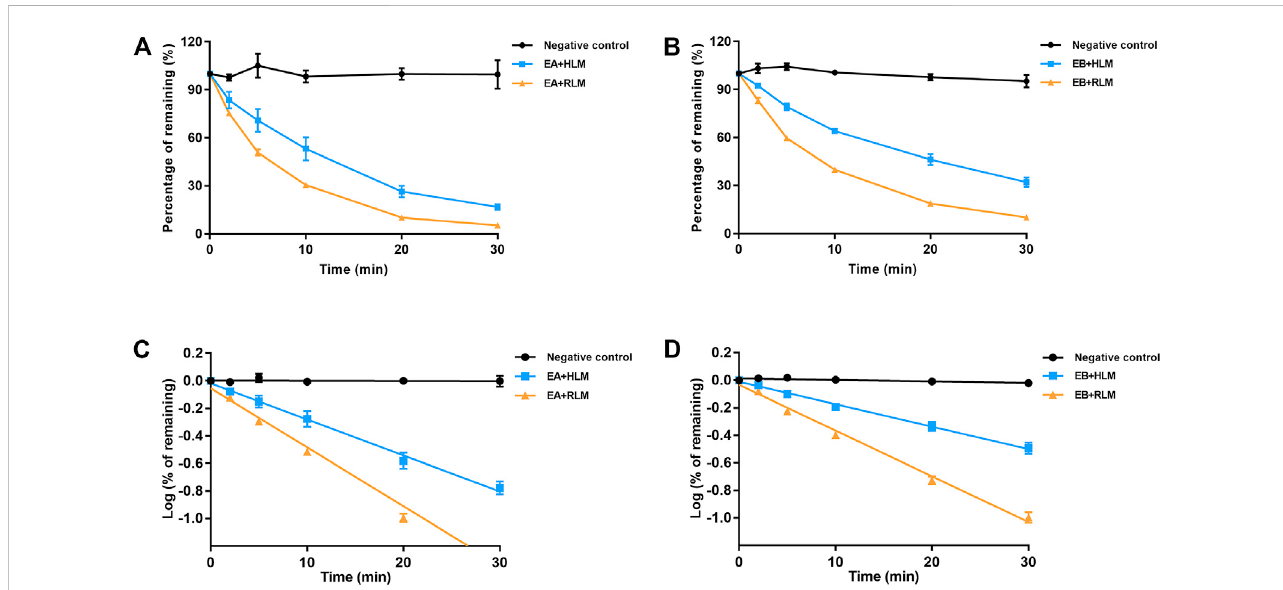
FIGURE 7 Comparison of EA (A,C) and EB (B,D) hydrolysis in HLMs or RLMs. Deactivated microsomes were used as negative control (mean ± SD; n = 3).